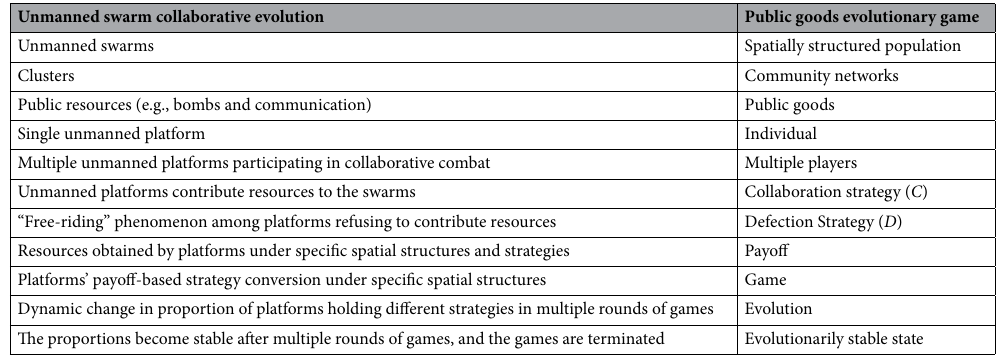
Table 1. Relationships between concepts of unmanned swarms on community networks and the multiplayer public goods